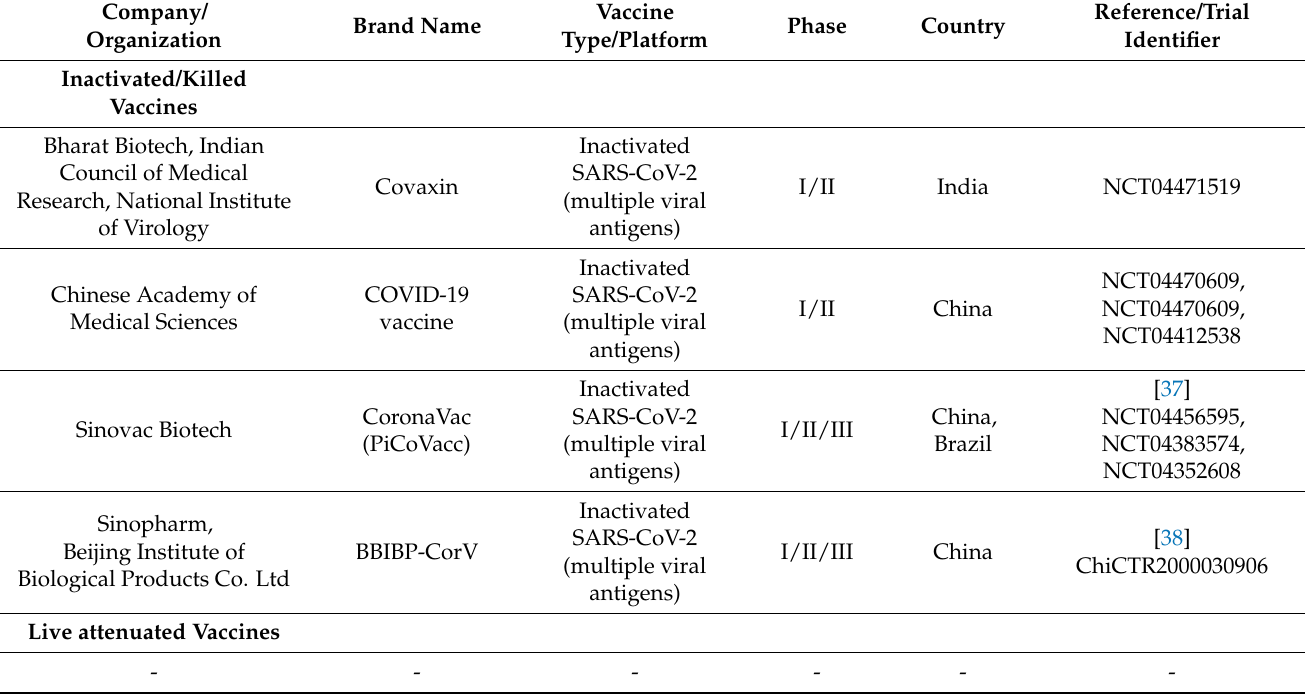
Table 1. Current COVID-19 vaccines in clinical